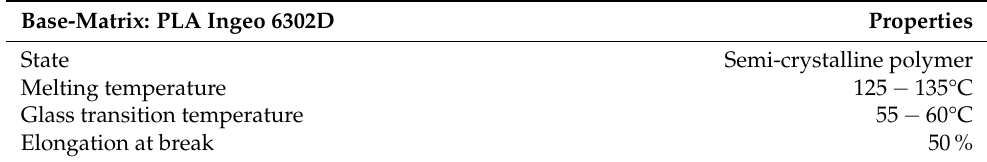
Table 5. Material properties of the type B base-matrix material. Base-Matrix: PLA Ingeo 6302D